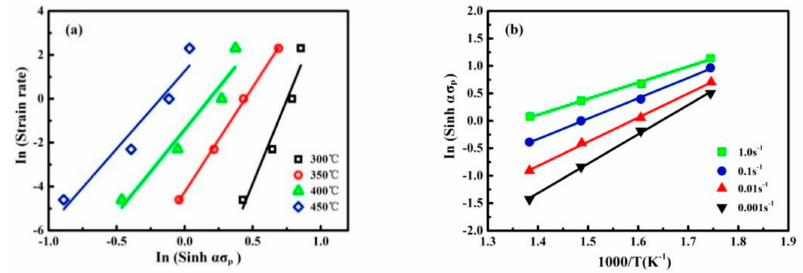
Figure 8. Relationship between ( a ) ln E and ln(sinh( ασ p )) and ( b ) ln(sinh( ασ p )) and 1000 / T .